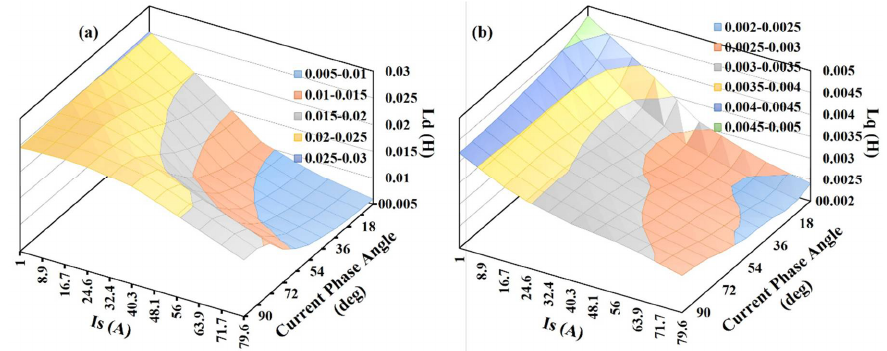
Figure 7. d-q- axis inductance of PMa-SynRM: ( a ) L d , ( b ) L q .